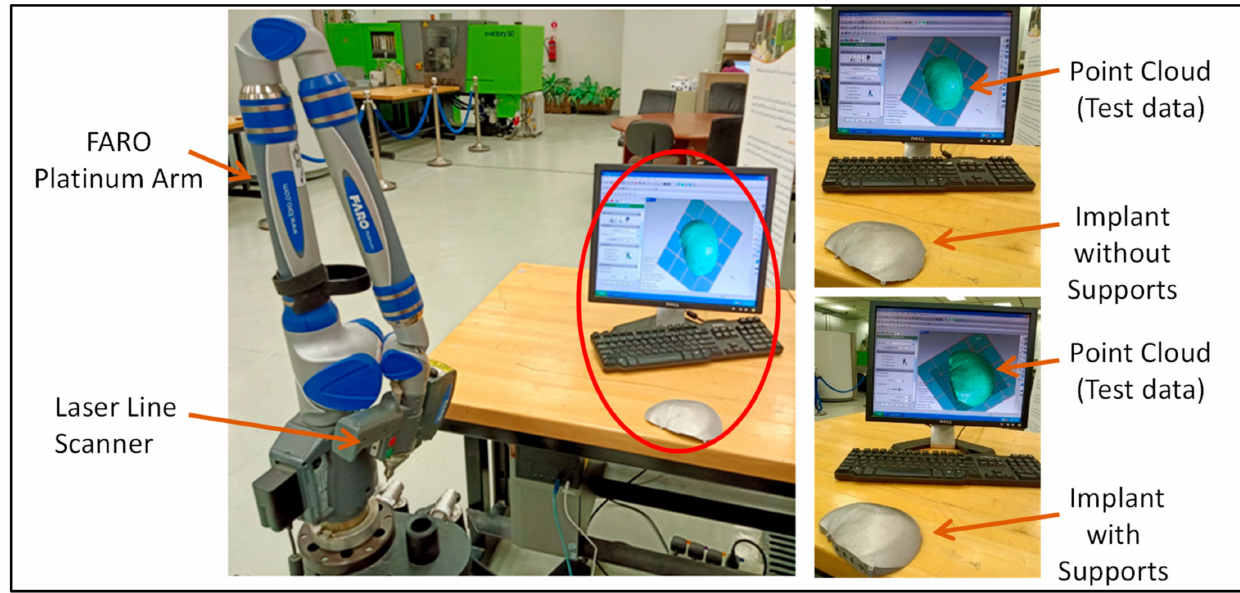
Figure 13. Set up to capture point cloud data for the fabricated